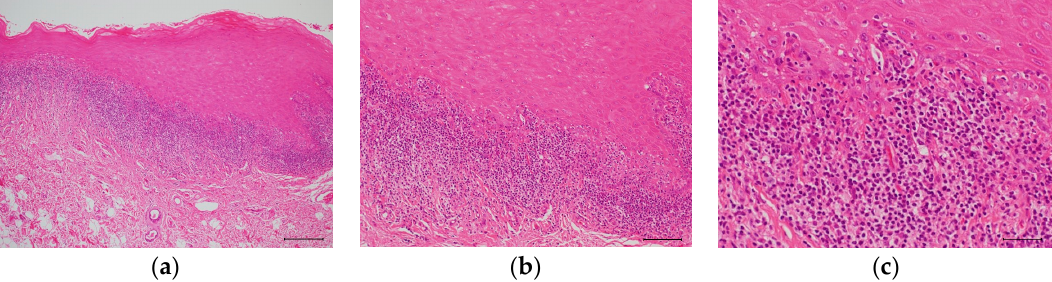
Figure 3. Hematoxylin and eosin (H&E) staining of an OLP tissue section. ( a ) Low power photomicrograph. Hyperkeratosis is presented on the surface of the epithelium and a band-like infiltrate of lymphocytes immediately subjacent to the epithelium. Scale bar: 100 µm. ( b ) Medium power photomicrograph. The rete ridge has a saw-toothed shape. Scale bar: 50 µm. ( c ) High power photomicrograph. Migration of lymphocytes into the lower epithelium is observed with liquefaction degeneration of the basal layer. The epithelial spinous cell layer directly contacts the infiltrating lymphocytes. Scale bar: 25 µm. Table 5. Proposed etiology of OLP.